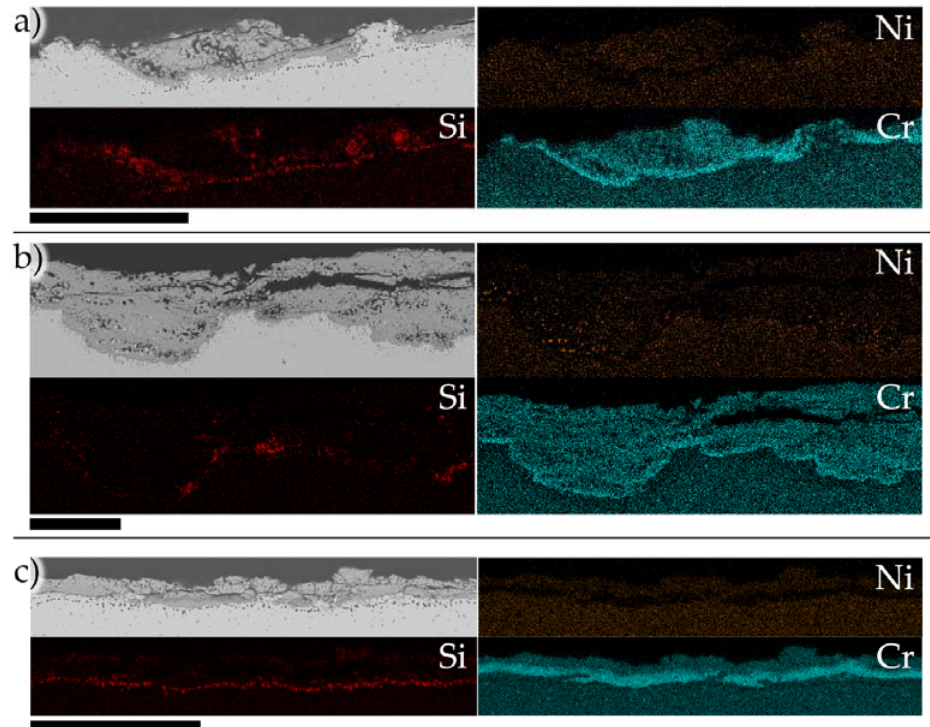
Figure 12. BSE image and corresponding energy dispersive X-ray (EDS) maps for Ni, Si and Cr in 1225 ◦ C for ( a ) air atmosphere, ( b ) oxyfuel atmosphere and ( c ) lean oxyfuel atmosphere. Scale bar is 50 μ m.